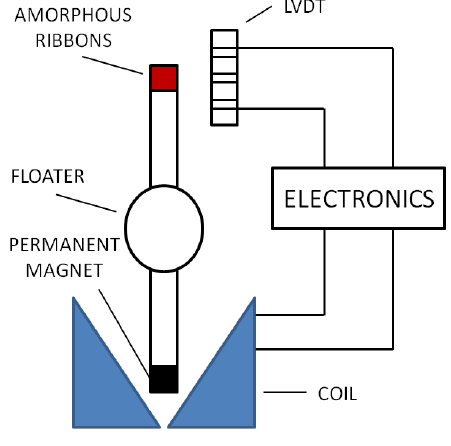
Figure 16. Density sensor